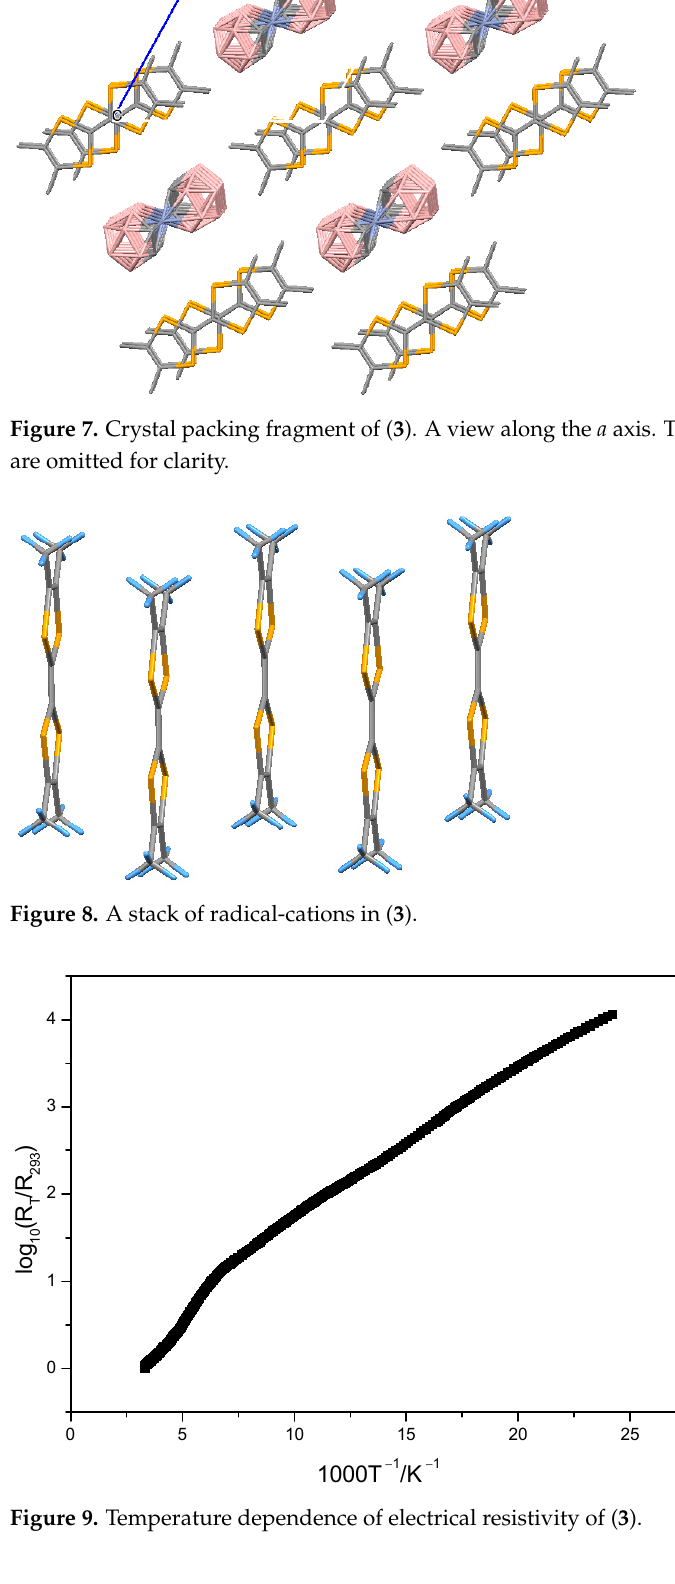
Table 1. Crystal data and structure refinement for (TMTTF)[3,3 ′ -Cr(1,2-C 2 B 9 H 11 ) 2 ] ( 1 ), (TMTTF)[3,3 ′ -